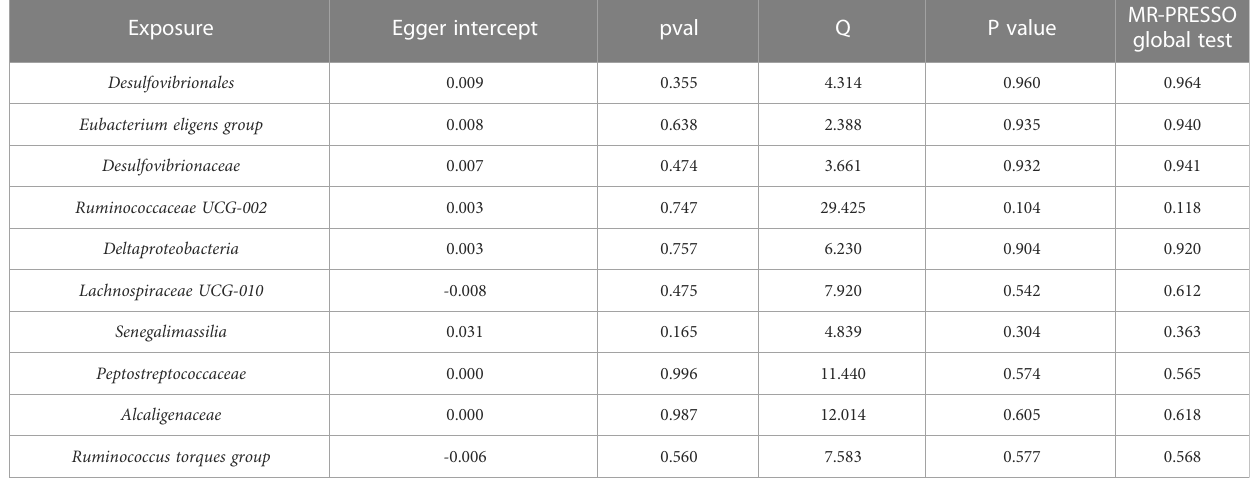
TABLE 2 Sensitivity analysis for signi fi cant and nominal signi fi cant estimates.